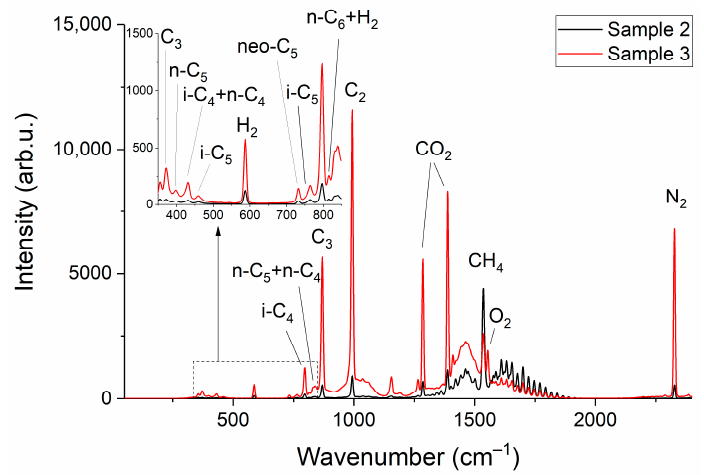
Figure 3. Raman spectra of sample 2 and sample 3.